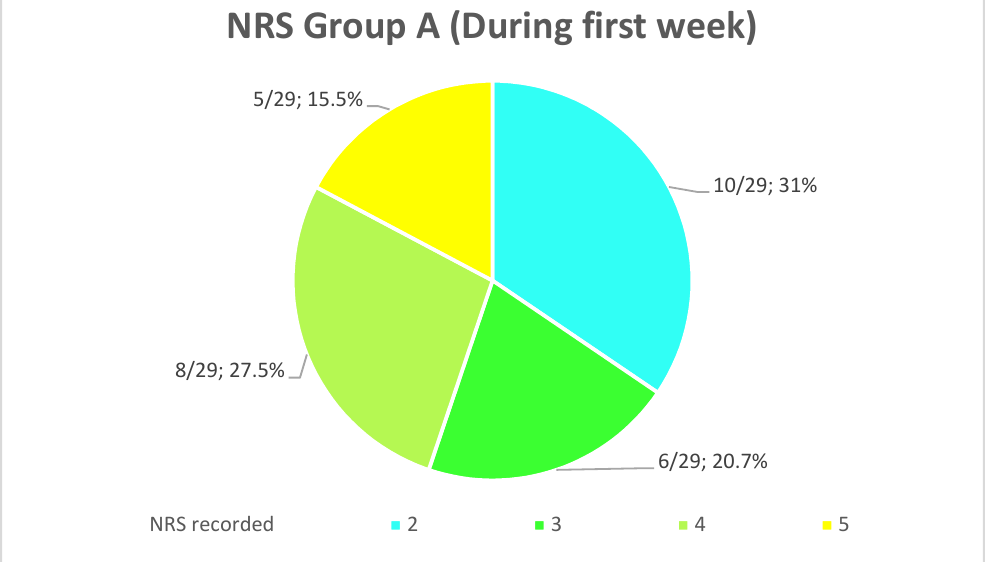
Figure 13. Distribution (numerical and percentage) of the NRS recorded in patients of Group A the first week after surgery.